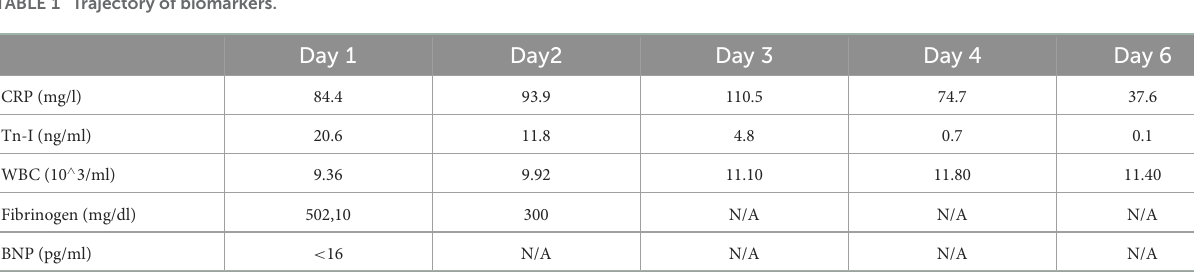
TABLE 1 Trajectory of